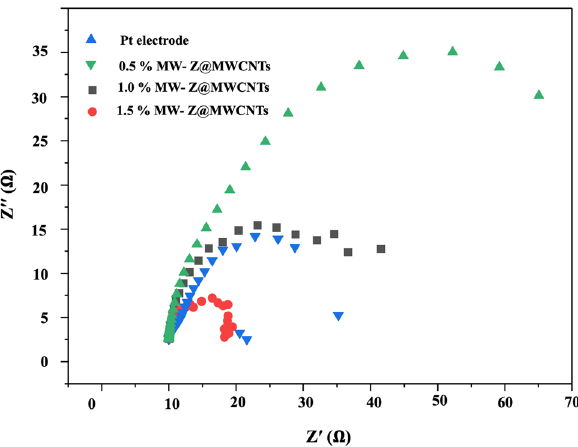
Figure 10. EIS analysis of the fabricated DSSCs with ZnO nanoflowers, MoWO 4 , and